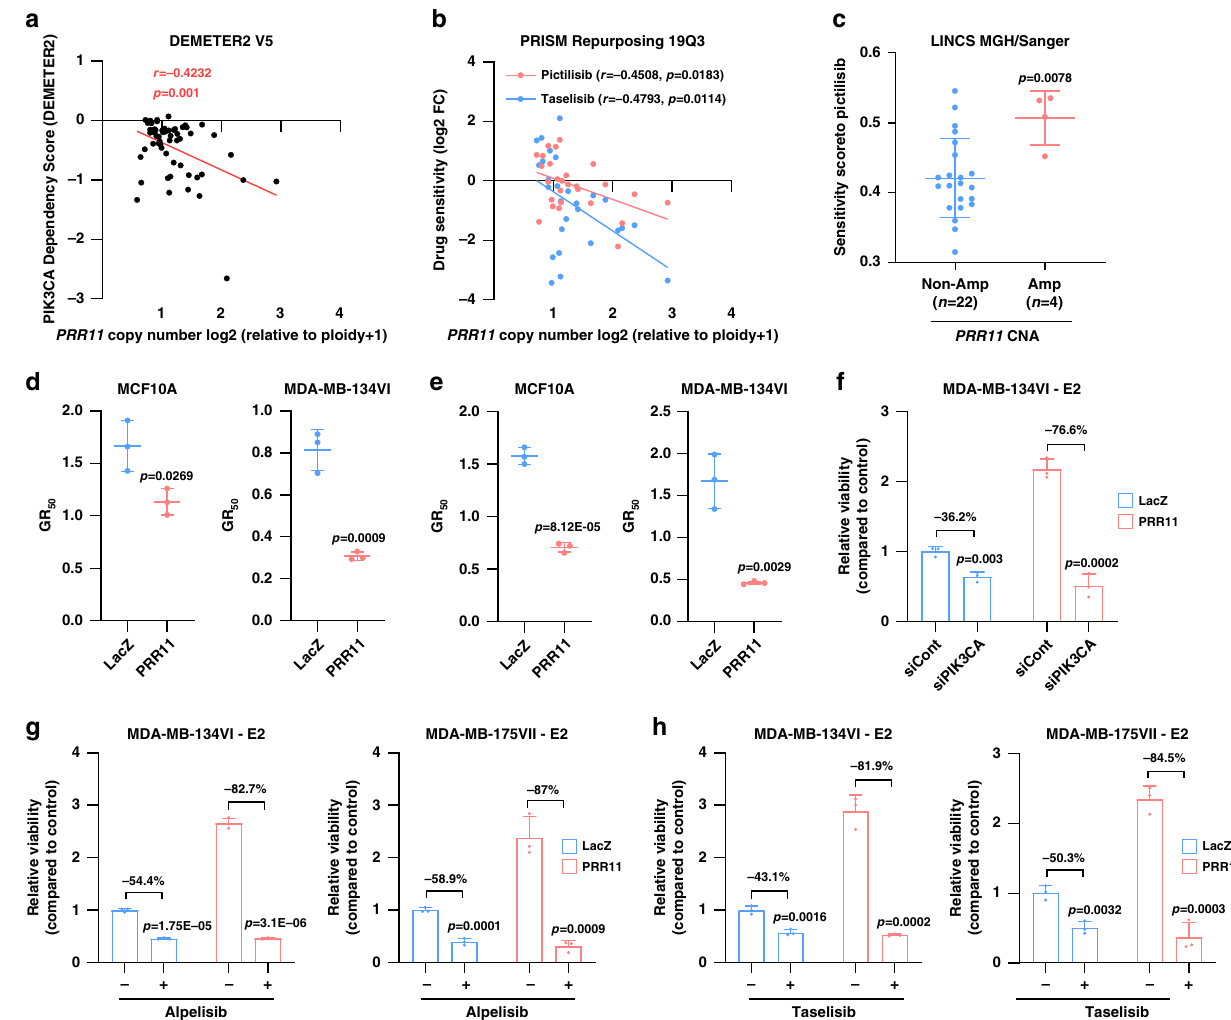
Fig. 7 PRR11 -ampli fi ed breast cancer cells are dependent on the PI3K pathway. a PIK3CA dependency scores of 57 breast cancer cell lines were plotted against PRR11 copy number (DEMETER2 V5 dataset; Pearson correlation). b Sensitivity of 27 breast cancer cell lines to pictilisib and taselisib was plotted against PRR11 copy number (PRISM Repurposing 19Q3 dataset; Pearson correlation). Y -axis shows the log 2 cell fraction as per the relative barcode abundance following drug treatment. c Pictilisib sensitivity score of 26 breast cancer cell lines in the LINCS MGH/Sanger dataset ( n = 22 and 4 for non- ampli fi cation and ampli fi cation group, respectively). Data represent the mean ± SD (two-tailed unpaired t -tests). d , e Alpelisib ( d ) and taselisib ( e ) GR 50 of MDA-MB-134VI and MDA-MB-175VII cells transduced with pLX302- LacZ or pLX302- PRR11 were calculated using the GR metrics calculator. Cell numbers counted at day 0 and day 6 were used as the input data. Data represent the mean ± SD of three replicates (two-tailed unpaired t -tests). f Low density monolayers of MDA-MB-134VI pLX302- LacZ and - PRR11 cells were grown in estrogen (E2)-free medium. After 14 days, cell monolayers were stained with crystal violet. Data represent the mean ± SD of three replicates (two-tailed unpaired t -tests). g , h Low density monolayers of MDA-MB-175VII and MDA- MB-134VI cells transduced with pLX302- PRR11 or pLX302- LacZ were treated ± 1 µ M alpelisib ( g ) or ± 1 µ M taselisib ( h ) in estrogen-free medium. After 14 days, cell monolayers were stained with crystal violet. Data represent the mean ± SD of three replicates (two-tailed unpaired t -tests). Source data are provided as a Source data fi Southwestern Medical Center. Eight-week old female ovariectomized athymic mice (Hsd:Athymic Nude- Foxn1 nu , Envigo) were implanted with a 14-day release 17 β -